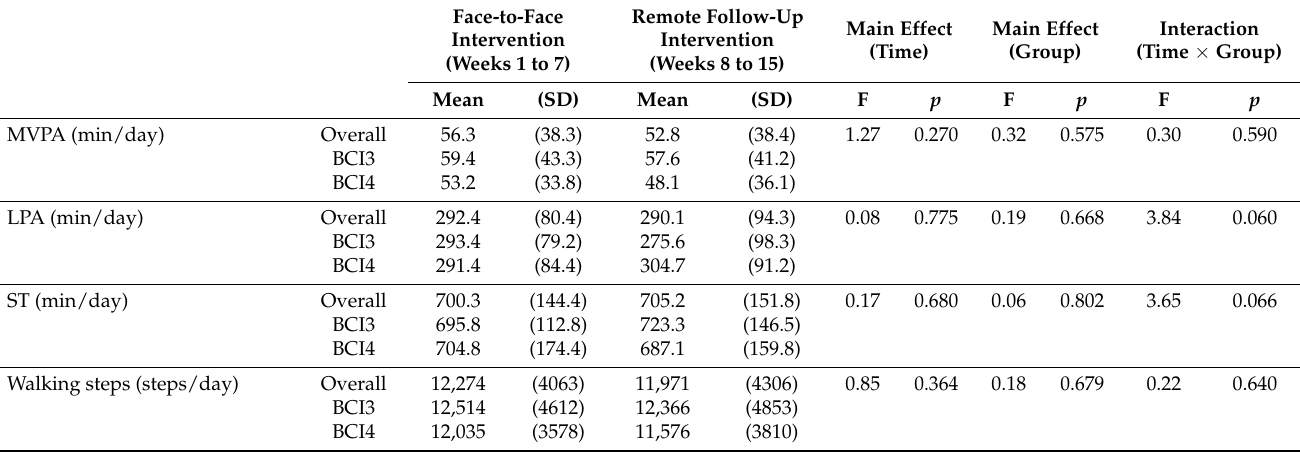
Physical activity, sitting time, and walking steps during face-to-face and remote follow-up